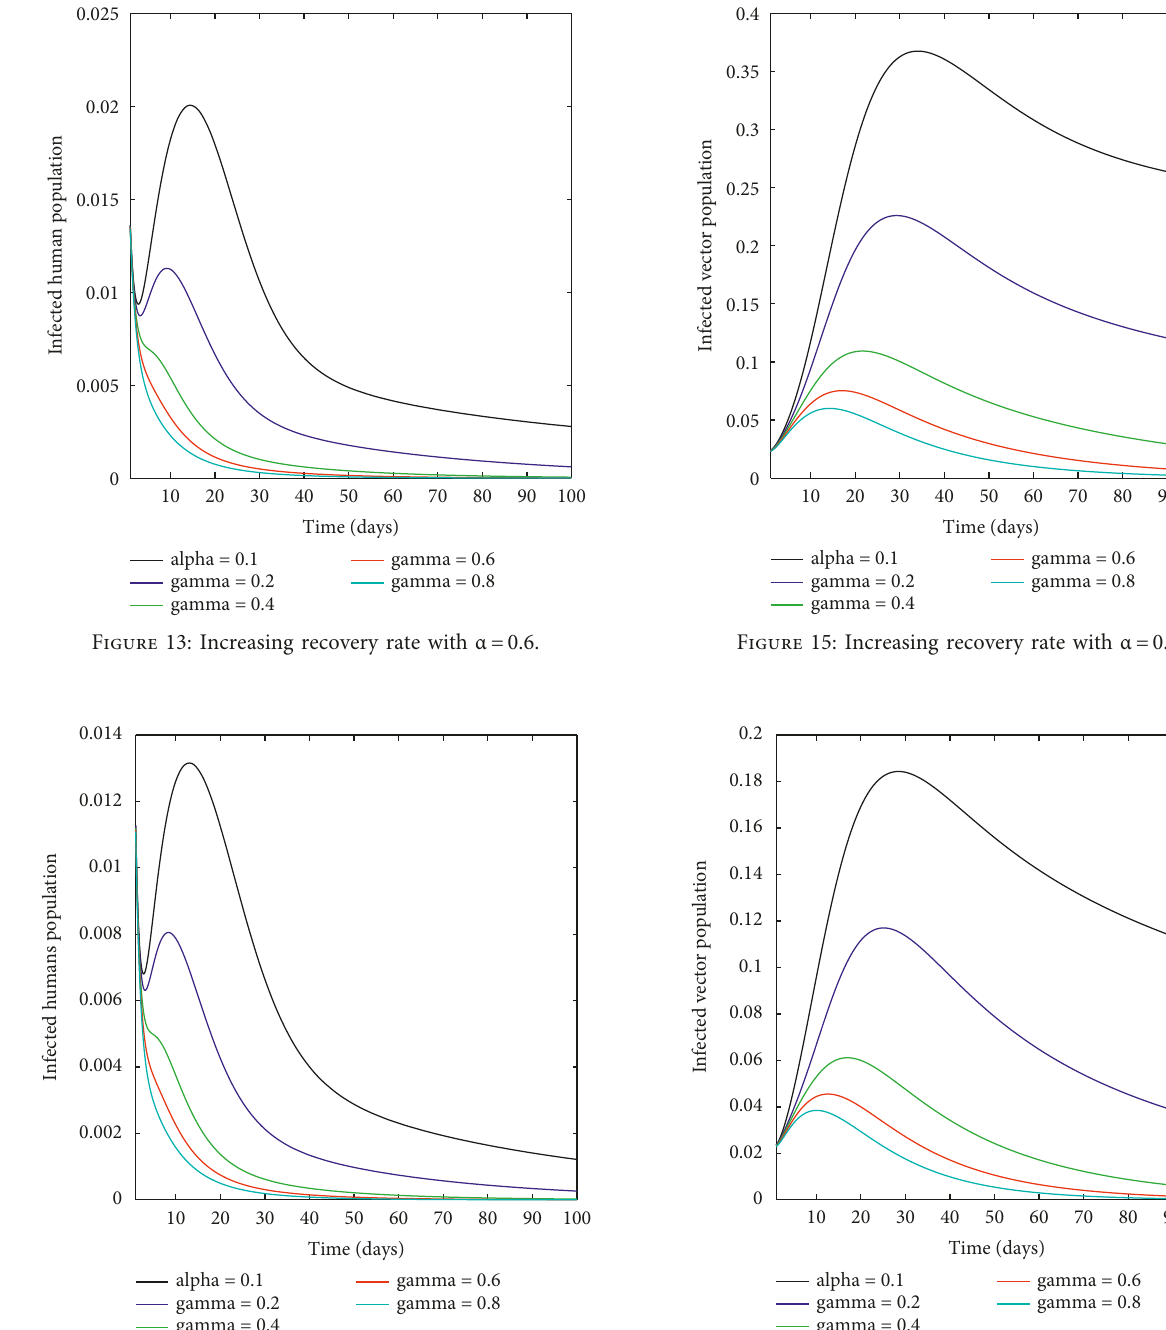
Figure 16: Increasing recovery rate with α �